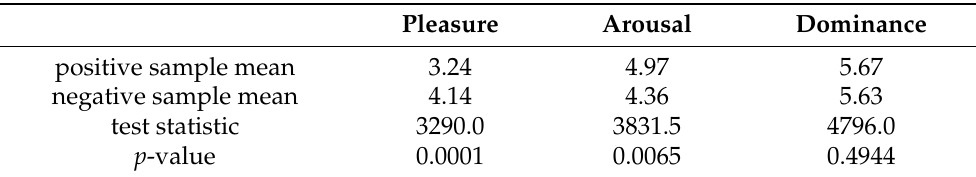
Figure 5. Distribution of ( a ) pleasure, ( b ) arousal and ( c ) dominance values, separately for teachers and subjects. Table 1. Comparing the distribution of PAD values for positive and negative opinions—mean values and results of Mann–Whitney test.